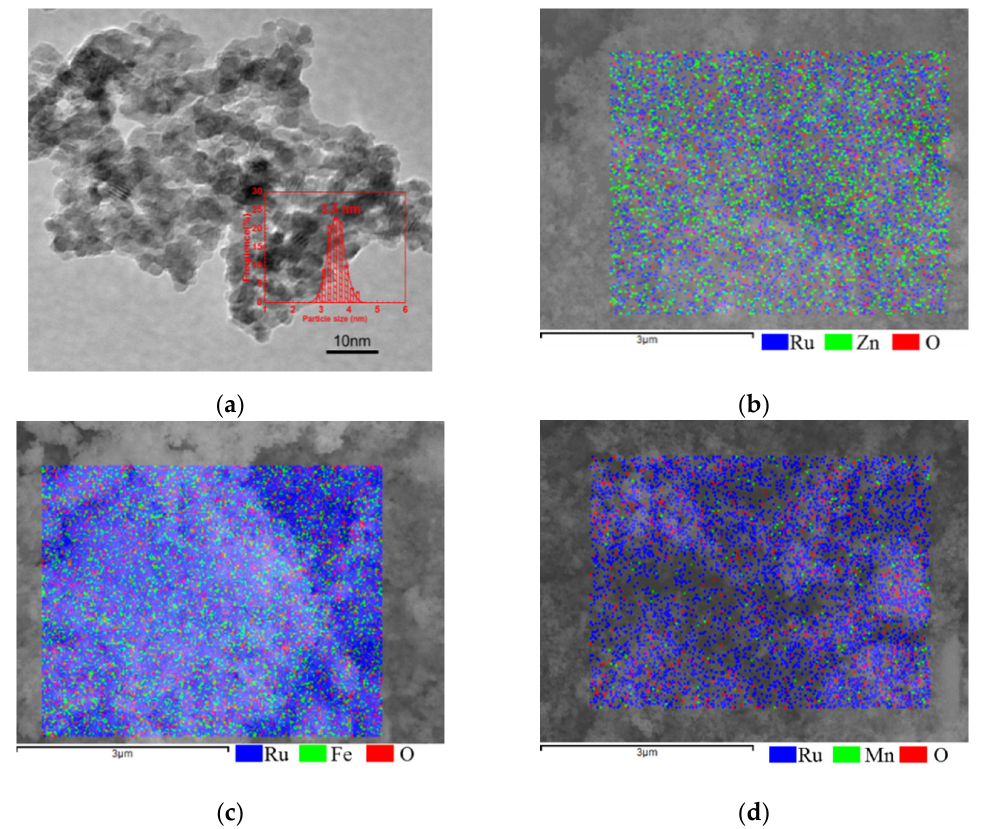
Figure 2. TEM images ( a ) as well as particle size distribution of the fresh Ru nanoparticles (insert image) and the SEM image as well as the element mapping image of Ru catalyst after catalytic experiments adding 0.57 mol L − 1 of ZnSO 4 ( b ), FeSO 4 ( c ), and MnSO 4 ( d